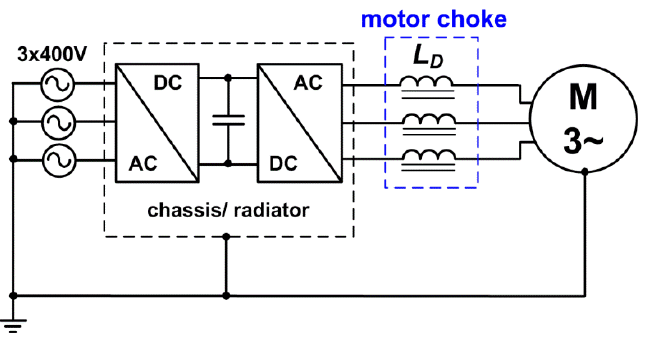
Figure 9. Electric drive with motor choke.